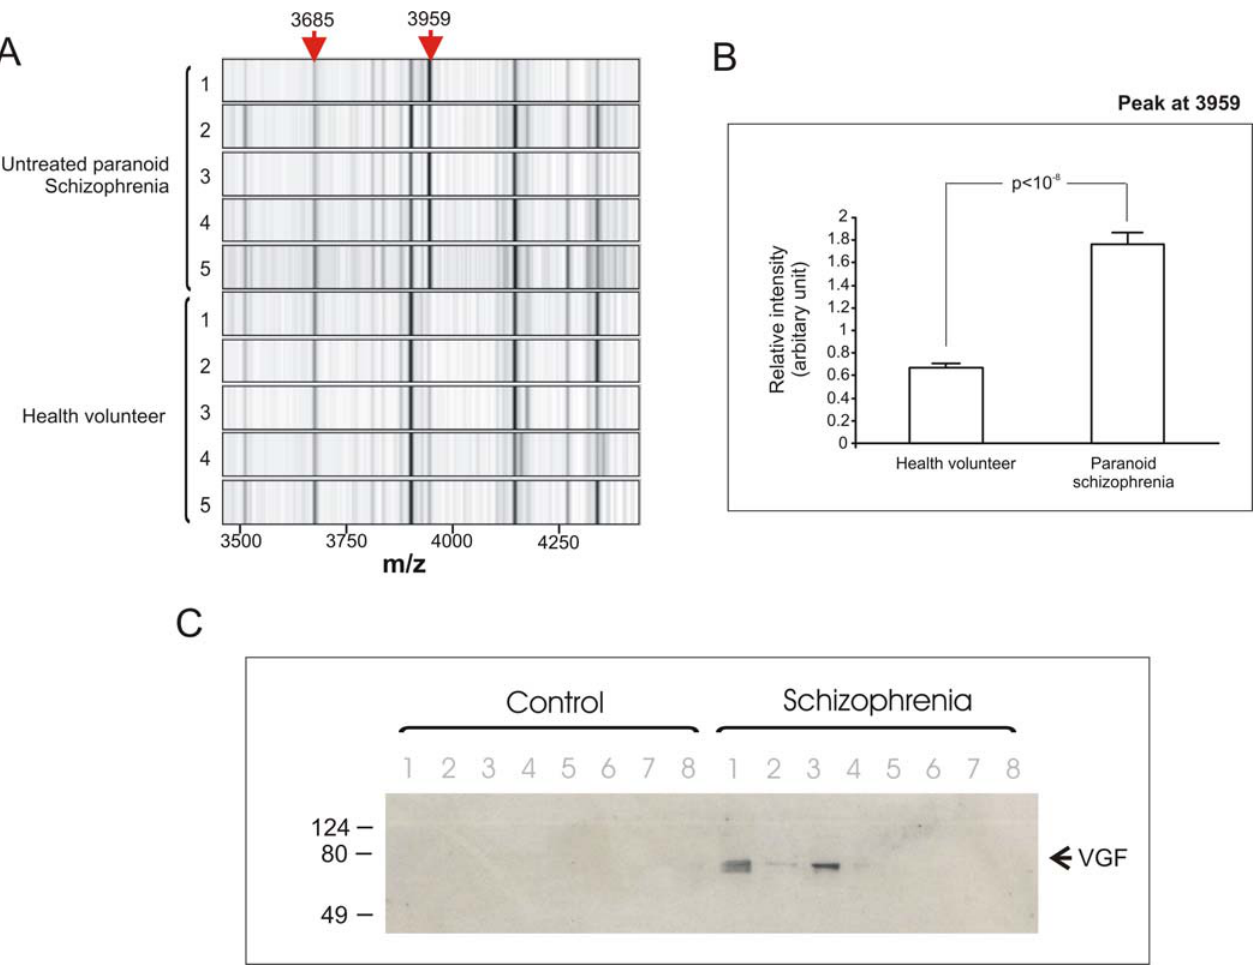
Figure 2. Up-Regulation of m/z ¼ 3,959 VGF23–62 Peptide Peak in CSF from First-Onset, Drug-Naı¨ve Schizophrenia Patients Forty healthy volunteers and 41 untreated paranoid schizophrenia CSF samples were included in this study. A clear up-regulation of the peak at 3,959 Da was observed (as shown in [A], with five representative spectra from each group). Figure 2B reveals the relative intensity of a 3,959-Da peak in healthy volunteers and first-onset, drug-naı¨ve schizophrenia patients. Figure 2C shows a Western blot analysis of VGF protein in the prefrontal cortex of age-matched controls and patients with schizophrenia. Eight schizophrenia and eight control brains (prefrontal cortex, age matched) were randomly selected, and Western analysis was performed using a polyclonal antibody against the C-terminal region of the VGF protein. VGF was found up- regulated in four patients with schizophrenia (out of eight patients), while no signal was detected in the control patients. This experiment was repeated twice on the same samples under identical conditions, except that a different batch antibody from the same company was used. Similar results were obtained. For demographic details, see Table